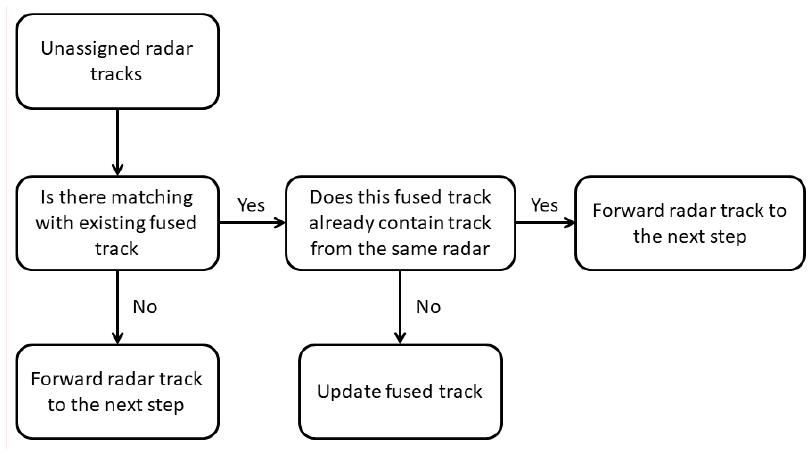
Figure 3. 2 of the data fusion algorithm.